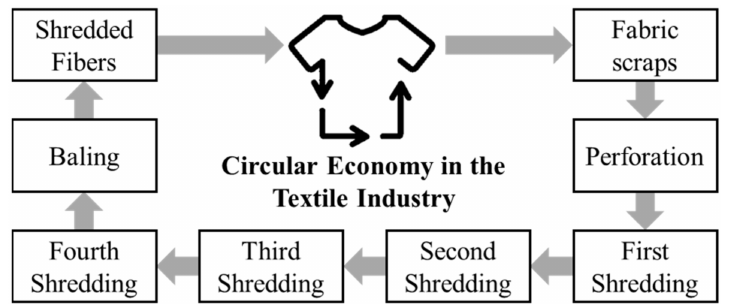
Figure 4. Process for the mechanical recovery of cotton fiber.